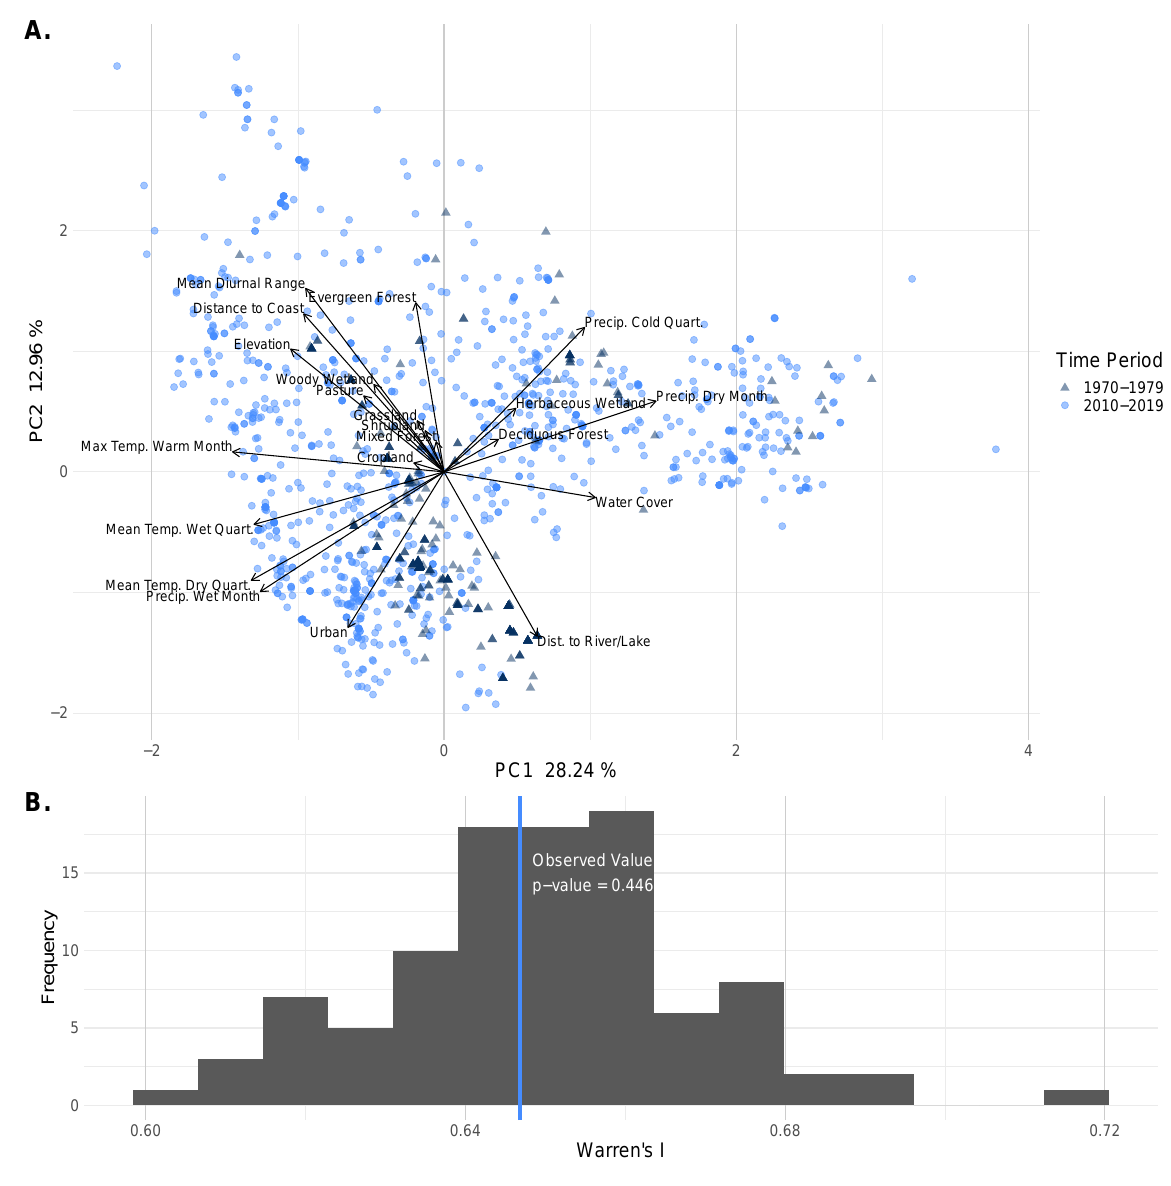
Supplementary Figure 4 – Results of the niche similarity test between the historic (1970-1979) and current (2010-2019) time periods for the boat-tailed grackle. (A) Species occurrence points plotted along the first two principal component (PC) axes used for the niche similarity test. The percent variance captured by each principal component is presented in the axis label. The black lines expanding from the origin indicate the rotation values for the environmental predictors along the two principal components. The current time period observations were randomly subsampled to 1000 points for visual clarity. (B) Values of Warren’s I from the niche similarity test based on the observed data (solid line) and 100 simulations (histogram). Higher values of Warren’s I indicate greater niche similarity. The p-value presented for the observed value is based on the null hypoth- esis that the observed value presents equal or greater niche similarity than the